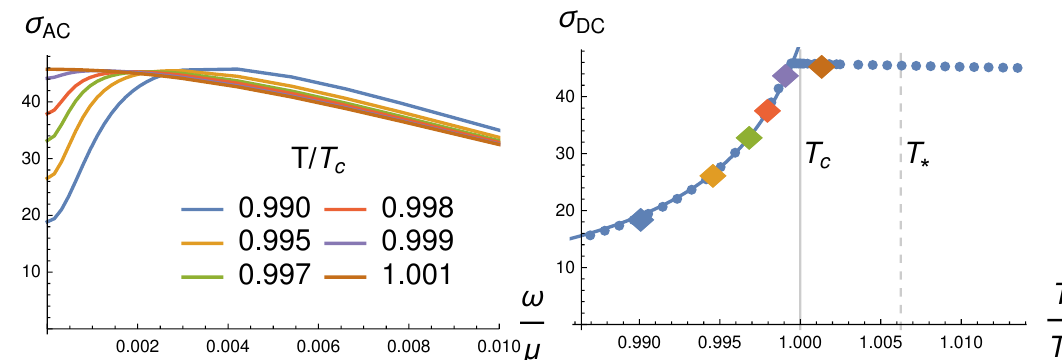
Figure 9. Left panel. AC conductivity across the phase transition for the helical model. Unlike periodic case figure 6, a sharp depression develops in the relatively wide Drude peak below T . The c loss of the spectral weight at small ω is compensated by the increase at larger ω . We show the data for λ = 0 . 5 µ, p = 2 . 16 µ . T 0 . 2221 µ . c c ≈ Right panel. DC conductivity across the phase transition. The blue dots correspond to the DC conductivity obtained directly from near horizon data [61]. The colored diamonds correspond to the zero frequency asymptotes of the AC conductivity curves from the left panel. Blue line is a fit with (4.5). The gridline shows a pole of the fit, which is located above T . Note complete analogy c with periodic case figure